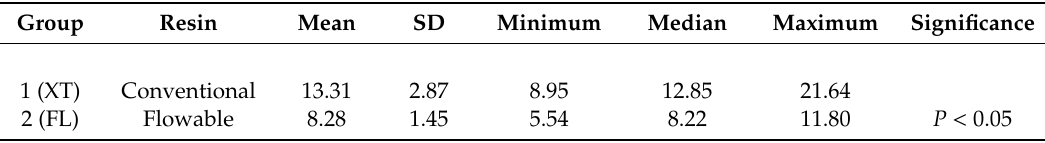
Table 2. Detachment forces (MPa) of the two resins